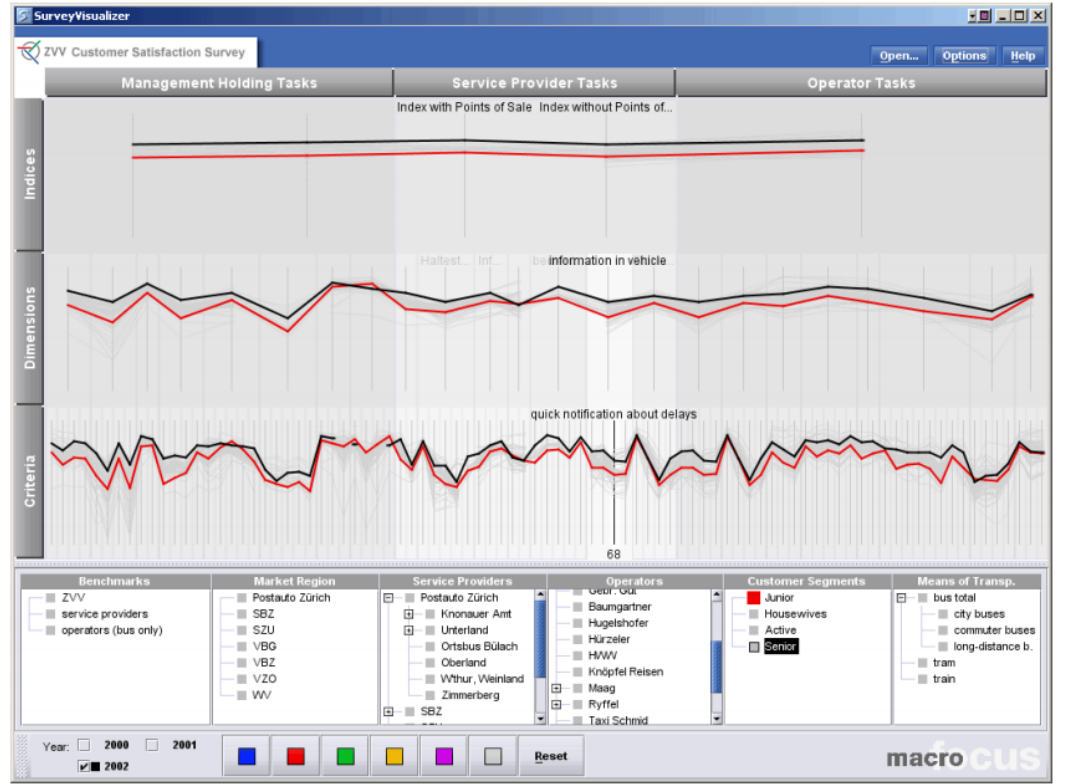
Figure 24. The three parallel coordinates represent each layer of the hierarchy. The file system tree-view below shows the data selection system where the user can choose subsets of the data to visualise [33]. Image courtesy of Broadbeck and Girardin